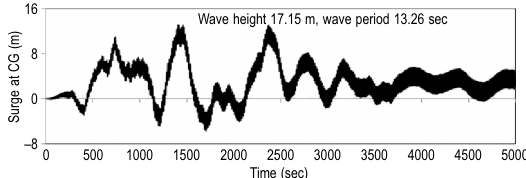
Fig. 5. Spar translational motion response in surge direction at